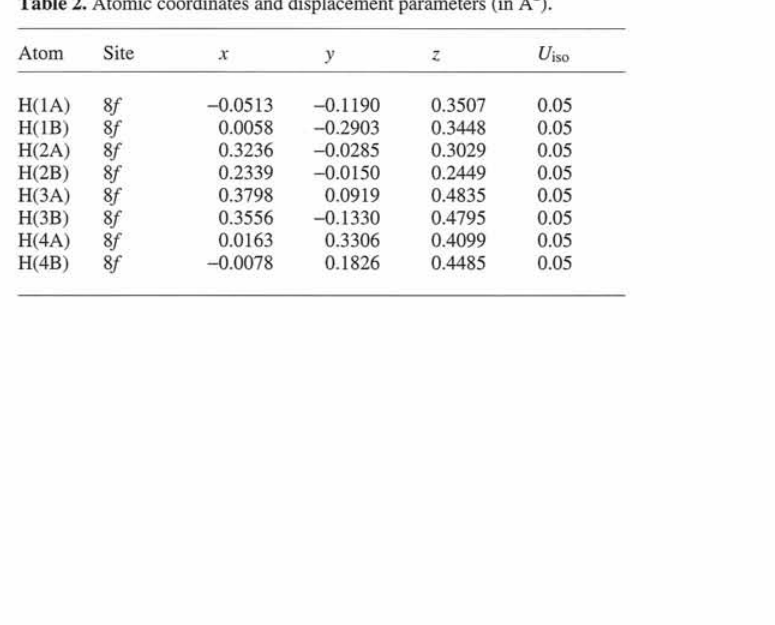
Table 2. Atomic coordinates and displacement parameters (in Â 2